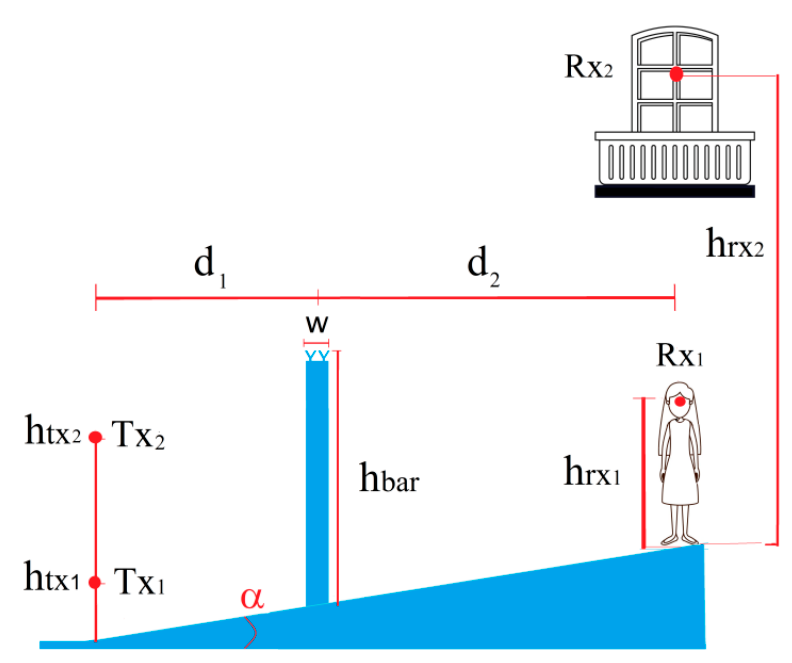
Figure 29. All configurations with a road slope at angle α .